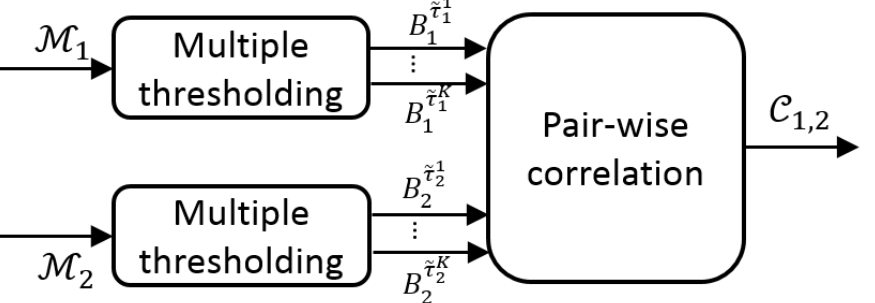
Figure 3. Cross correlation of detectors